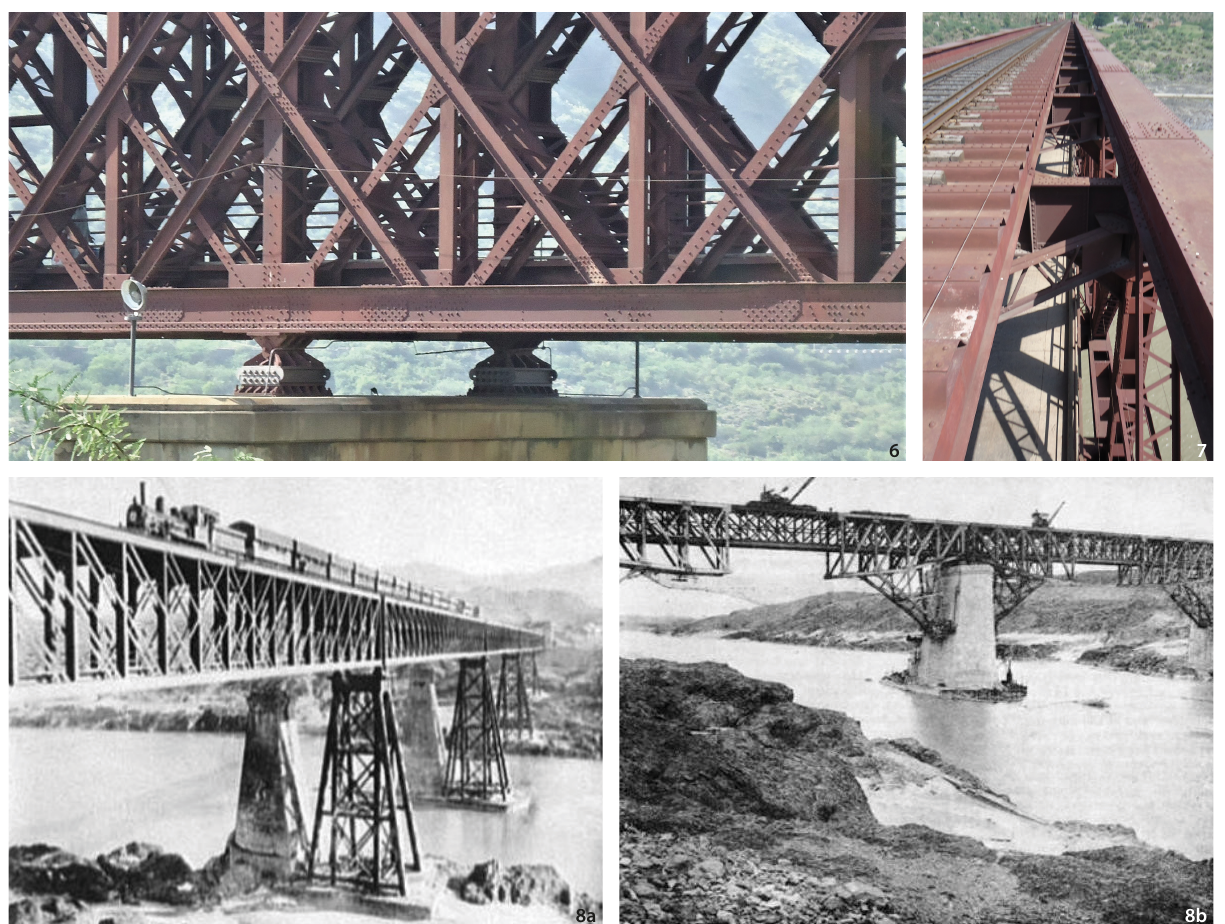
Figure 6 The innovative pre-fabricated steel girder design of Attock Bridge (Source: Baloch). Figure 7 Two- tier structure of Attock Bridge (Source: Baloch). Figure 8a Historical photos of the construction of Attock Bridge in 1900 (Source: Pakistan Railways). Figure 8b Historical photos of the construction of Attock Bridge taken during interventions in 1925 (Source: Pakistan